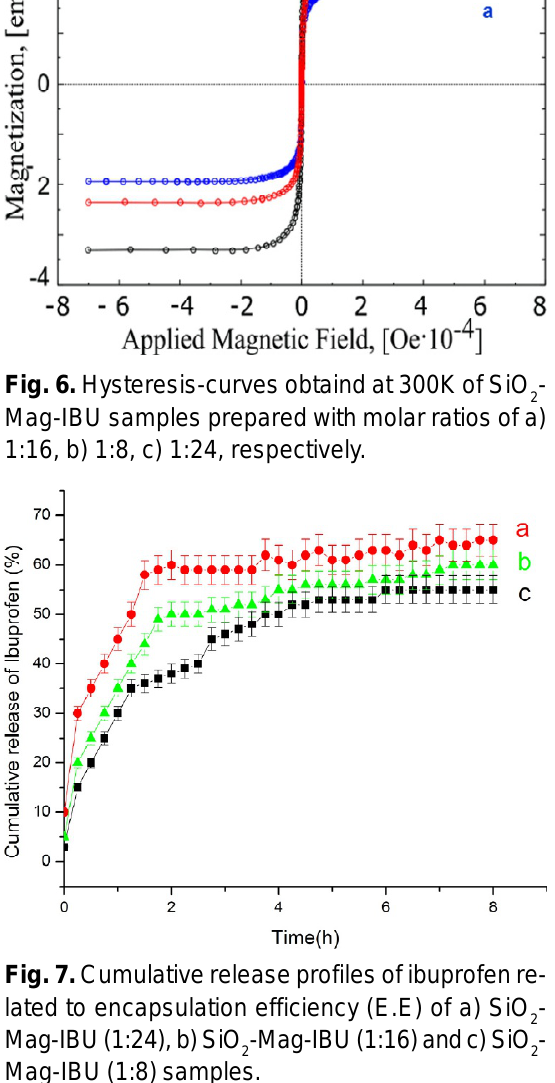
-Mag-IBU (1:16) and c) SiO 2